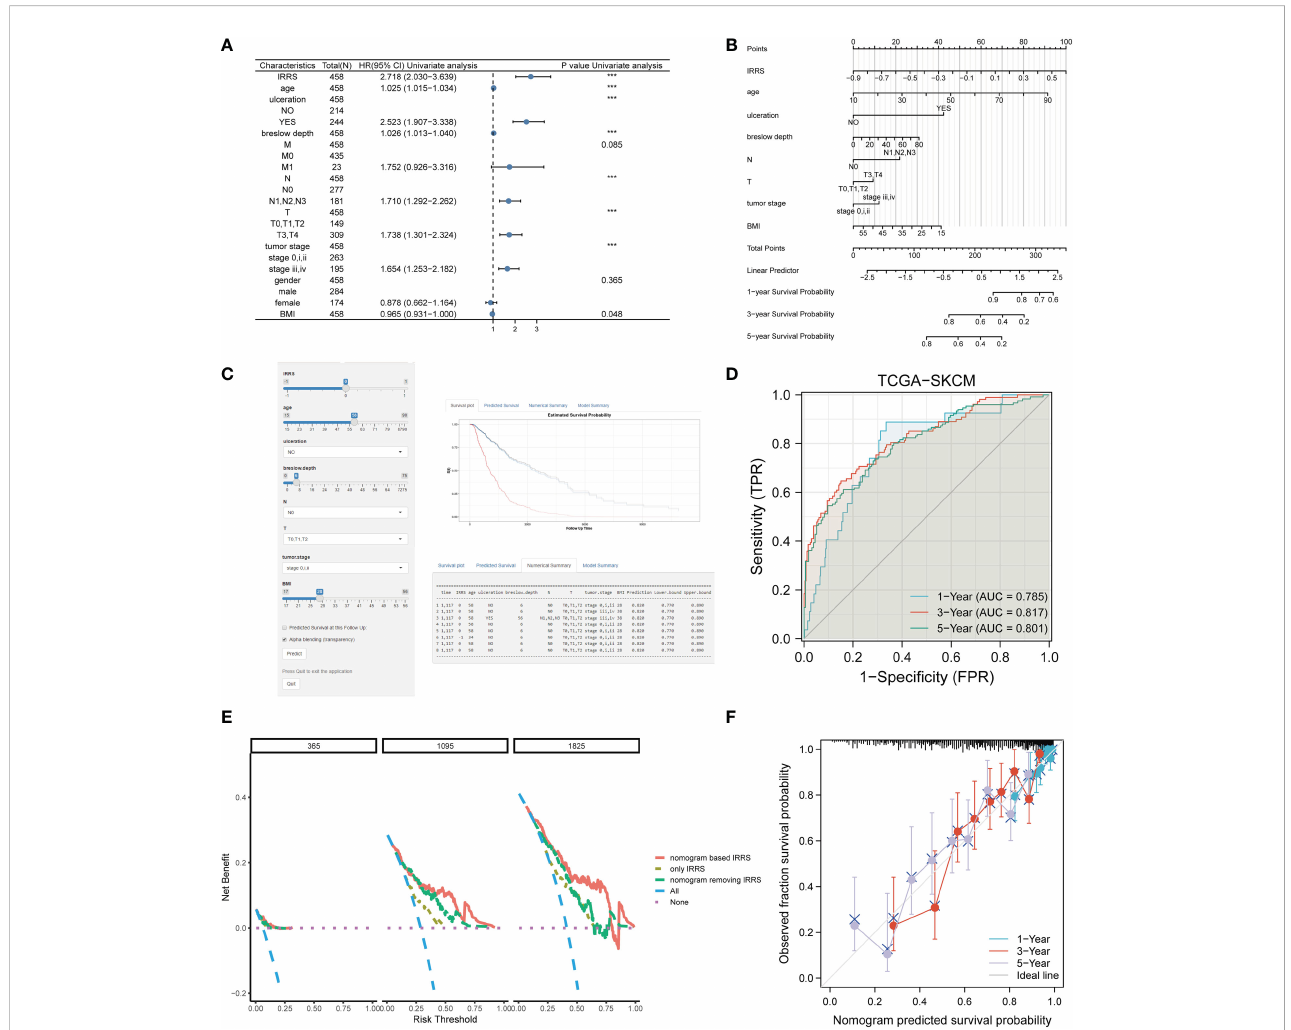
FIGURE 7 Construction of the nomogram. (A) The prognostic clinical factors screened based on uni-Cox regression. (B) The nomogram for predicting the survival rate of melanoma patients, including four independent clinical prognostic factors and the IRRS. (C) The online version of the nomogram. (D) The ROC analysis of the nomogram. (E) DCA of the nomogram. (F) The calibration curve of the nomogram.